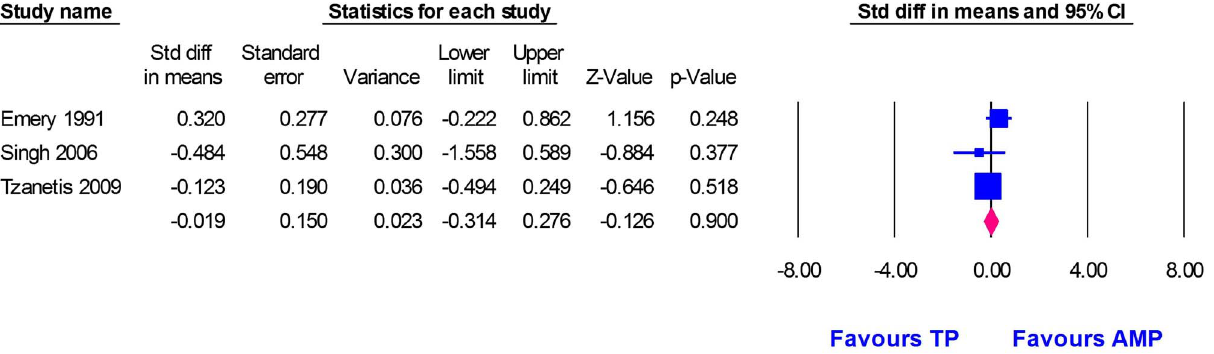
Figure 3. Forest plot of standardized mean difference (SMD) in functional scores with 95% con fi dence interval, comparing Thompson and Austin Moore groups.